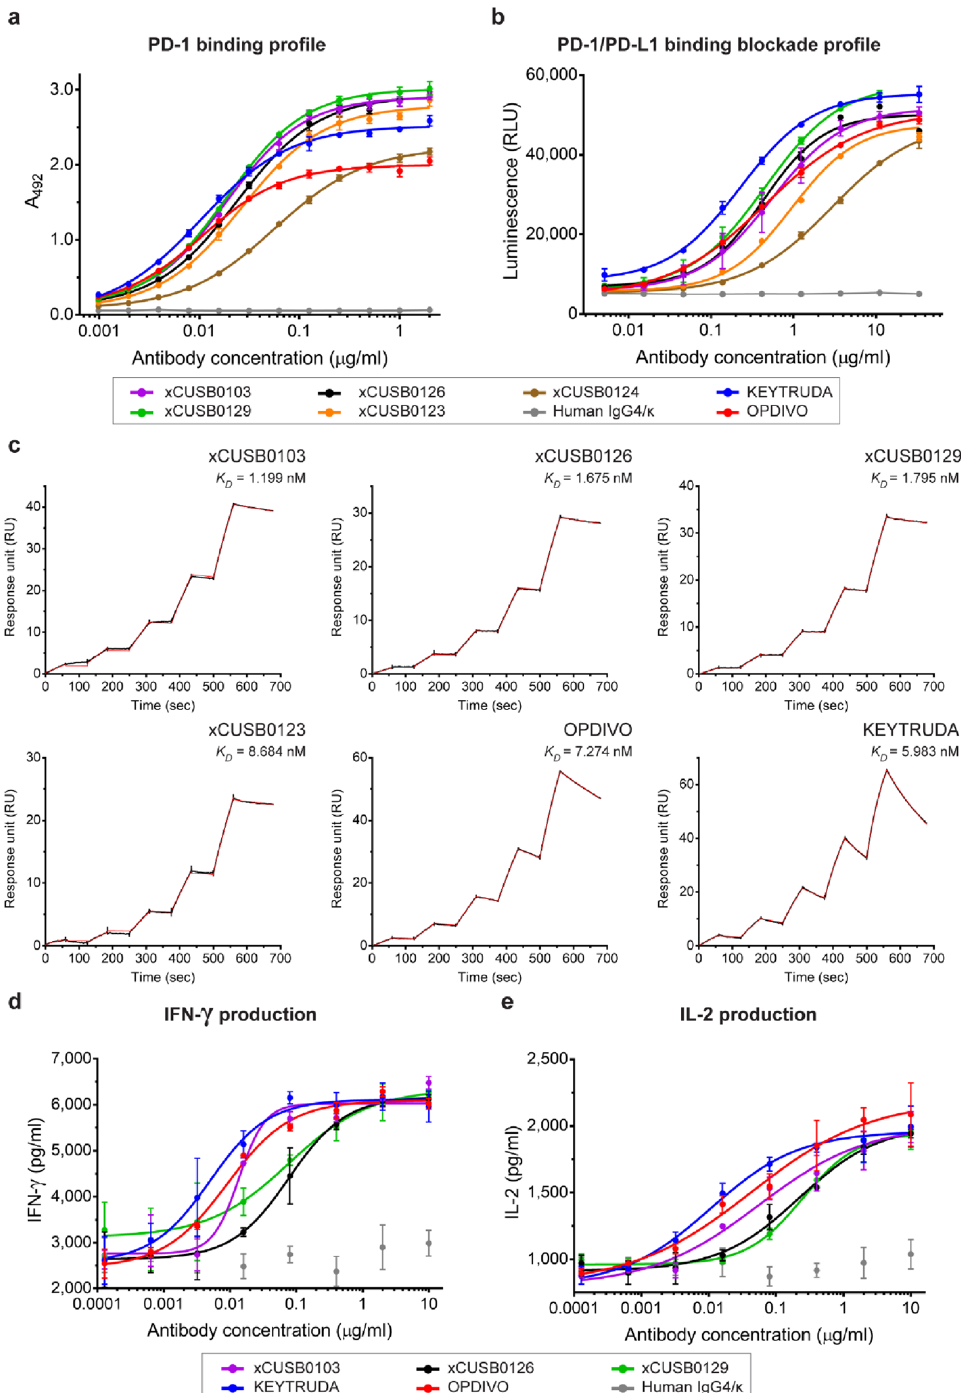
Figure 5. Functional characterization of chimeric anti-PD-1 monoclonal antibodies. (a) PD-1 binding profile of generated chimeric anti-PD-1 mAbs. ELISA was used to determine the binding activity. Data from triplicates are presented as the mean ± SD. (b) PD-1/PD-L1 binding blockade profile of generated chimeric anti-PD-1 mAbs. The PD-1/PD-L1 blockade bioassay was used to determine the PD-1/PD-L1 binding blockade activity. The results from triplicates are presented as RLUs as the mean ± SD. (c) Sensorgrams of the binding kinetics between the generated chimeric anti-PD-1 mAbs and the hPD-1 His tag assessed by SPR. Single-cycle kinetics were performed by sequentially injecting the hPD-1 His tag at various concentrations to capture chimeric mAb on a protein G sensor chip. The K D value was calculated using a 1:1 Langmuir model fitting curve and presented in the sensorgram. The potency of the generated chimeric anti-PD-1 mAbs on T cell activation was evaluated by the MLR assay. Serial dilutions of each chimeric mAb and antigen-presenting cells were coincubated with the effector cells. After coculture for 3 days, the secretion levels of (d) interferon gamma (IFN-γ) and (e) interleukin 2 (IL-2) were quantified. Data from triplicates are presented as the mean ± SD. Commercially available anti-PD-1 mAbs, KEYTRUDA and OPDIVO, were used as positive controls, while human IgG4/κ was used as a negative control in all